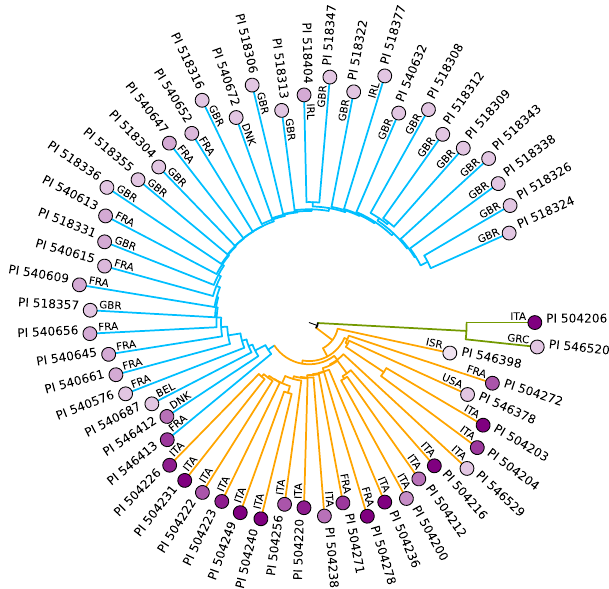
Fig. 7 Phylogenetic tree of accessions used in studies on Erysiphe resistance and available in the USDA/GRIN database. Branch colors refer to sea beets from the Atlantic coast (blue), from the Mediterranean coast (yellow), and to sea beets that we would classify as B. v. adanensis (green). Color gradient of nodes re fl ects the resistance classi fi cation from light (susceptible) to deep purple (resistant) according to passport data. Countries of origin according to passport data are